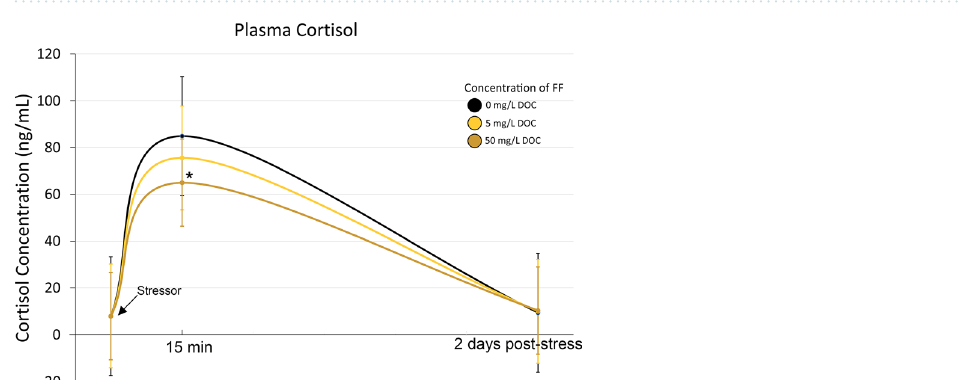
Figure 2. Plasma cortisol concentration after 28 days of exposure, 15 min post stressor (netting and 30 s air- exposure), and 2 days post-stress. N = 12, mean ± SD; *p < 0.05 against